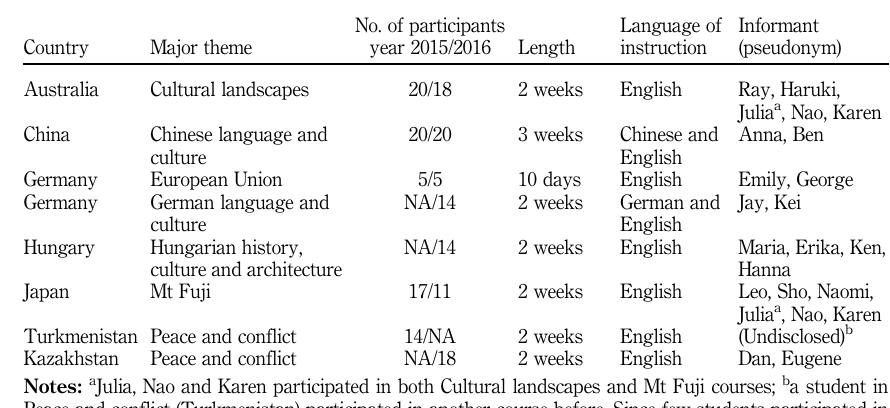
Table I. Summary of courses and informants ’